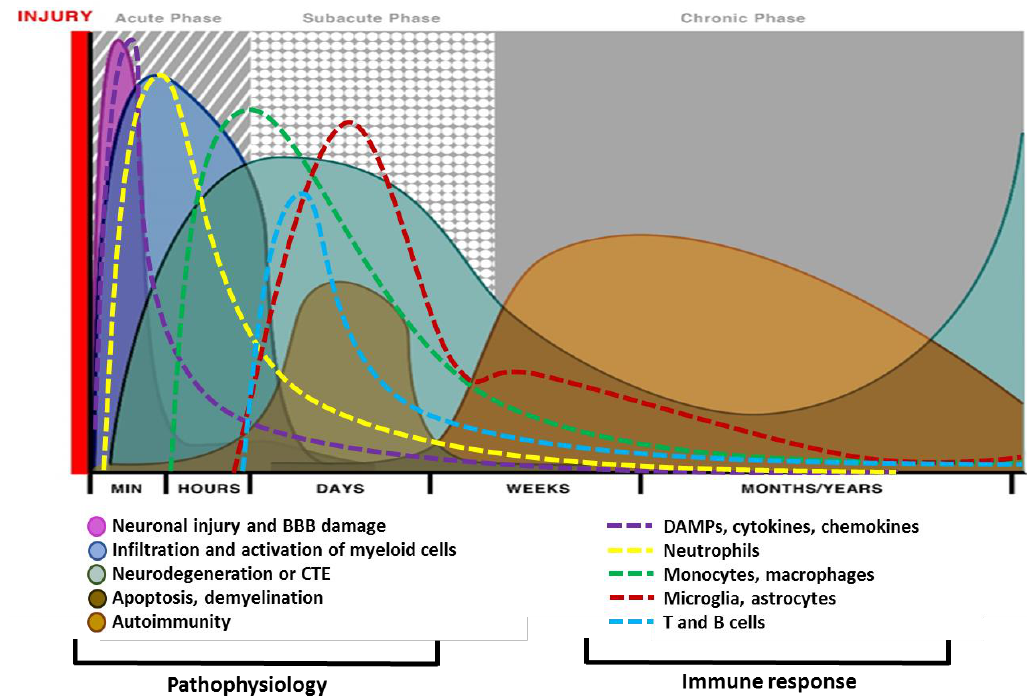
Figure 2. Different phases of traumatic brain injury (TBI) pathophysiology and relative immune response. Mechanical insult leads to acute neuronal injury and blood-brain barrier (BBB) damage, which initiates gliosis and glial injury minutes after TBI and continues for days after injury. Necrotic and apoptotic cell death start immediately after the insult and peak within h to days. Axonal shearing is another event that leads to demyelination and white matter injury. Neurodegeneration, traumatic encephalopathy, and axonal injury may sustain for years after a single TBI. Acute insult and neurovascular damage lead to myeloid accumulation and recruitment of T-cells that last for years and may cause chronic neurodegeneration and neuropathology. Immune cells respond to trauma in a timely manner and a differential pattern of activations has been observed by various studies. An impact to the head leads to cellular damage and results in the rapid release of damage-associated molecular patterns (DAMPs). DAMPs stimulate local cells to release inflammatory mediators such as cytokines and chemokines. These mediators recruit myeloid cells specifically neutrophils as first responders, which phagocytize debris and damaged cells promoting the containment of the injury site. As neutrophil numbers begin to decline, infiltrated monocytes and glia get activated and accumulate around the site of injury to perform further phagocytic or repair functions. Depending on the severity of the brain injury, myeloid cells can recruit T and B cells. T and B cells appear at the sites of brain pathology at later time points in the response (3–7 days post-injury) and may persist for weeks to months. Other abbreviation is as CTE: Chronic traumatic encephalopathy.